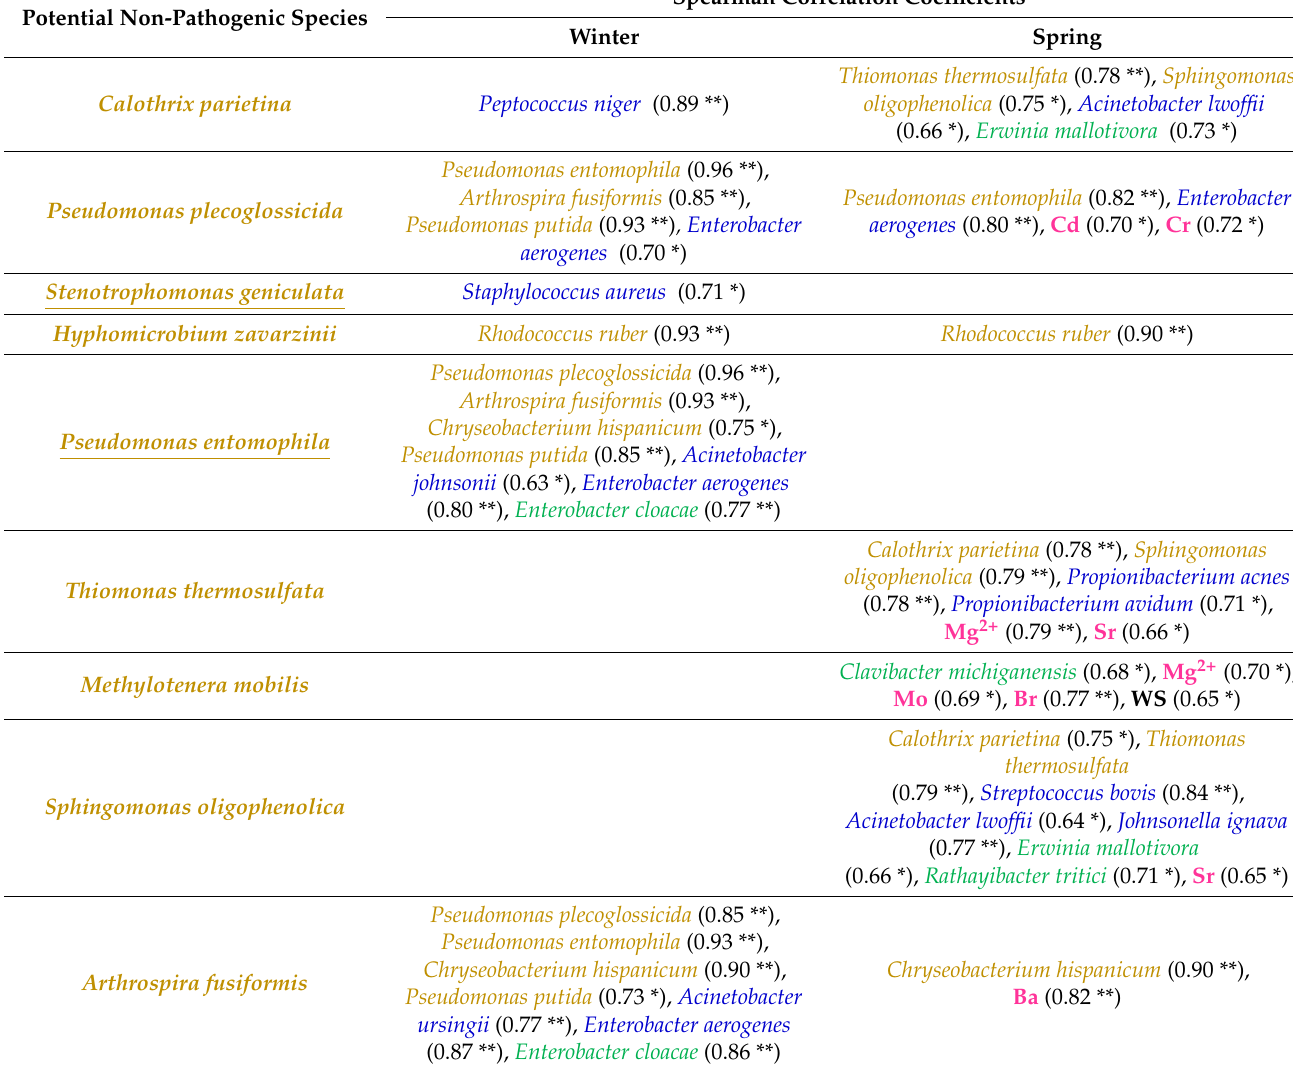
Table 3. Relationships between the 10 most abundant potential and pervasive non-pathogens (ochre) and with the 10 most abundant potential and pervasive human pathogens (blue), the most abundant and pervasive plant pathogens (green), PM10 (grey) and chemical species (pink) mass concentrations, and meteorological parameters (black) in winter and spring samples. The related Spearman correlation coefficient is reported in brackets (values significant at a p -level < 0.05 and 0.01 are marked by * and **, respectively). Underlined and bold-italic species represent the ones only found in winter and spring,